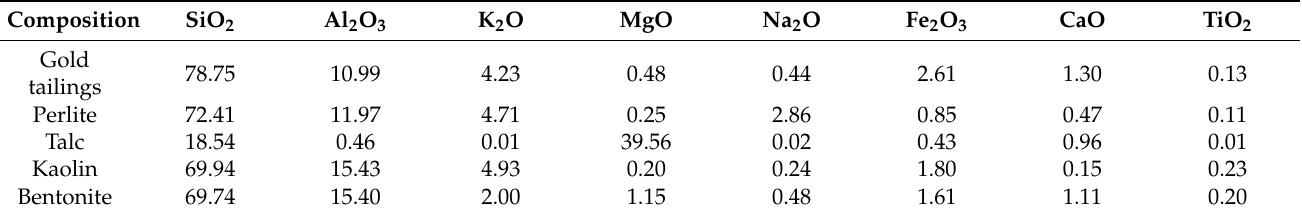
Table 2. Chemical composition of the various raw materials used for foam ceramic preparation.